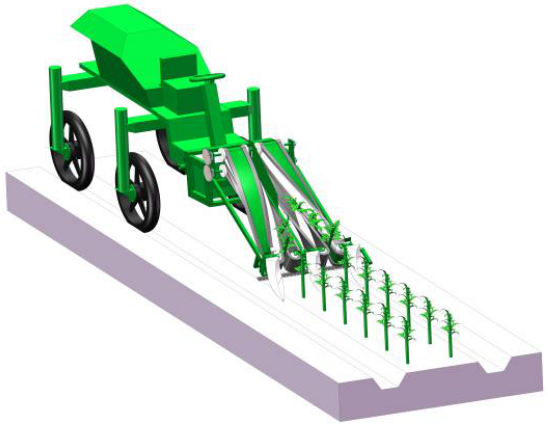
Figure 2. Rape shoot harvesting.